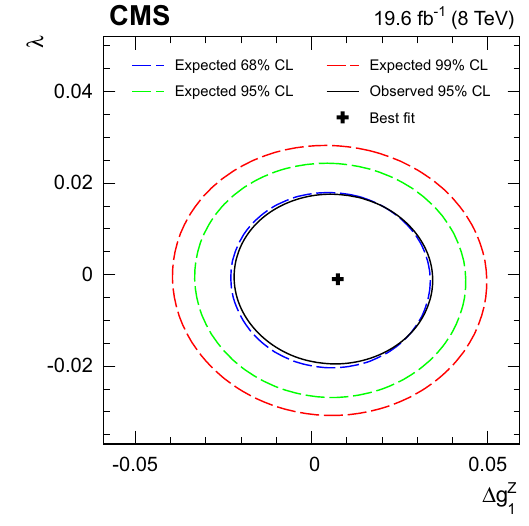
Fig. 9 Two-dimensional observed 95% CL limits and expected 68, 95 and 99% CL limits on anomalous coupling parameters (cid:7) g Z